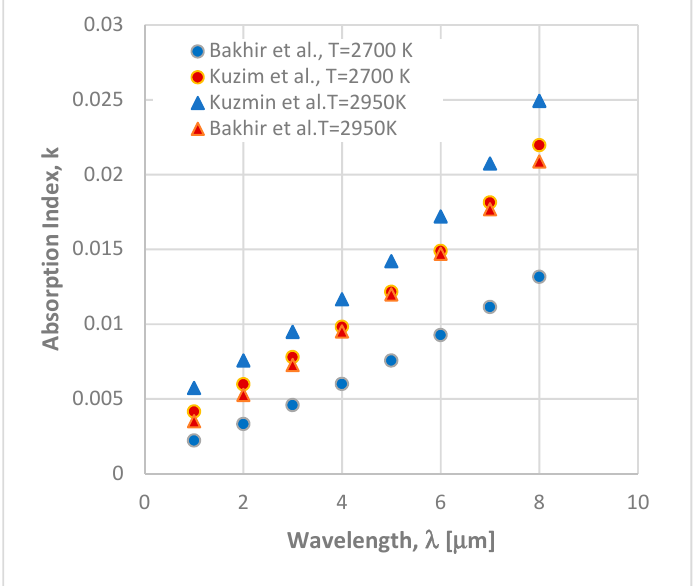
Figure 1. Analytical absorption coefficient in function of the wavelength and temperature [11,15].